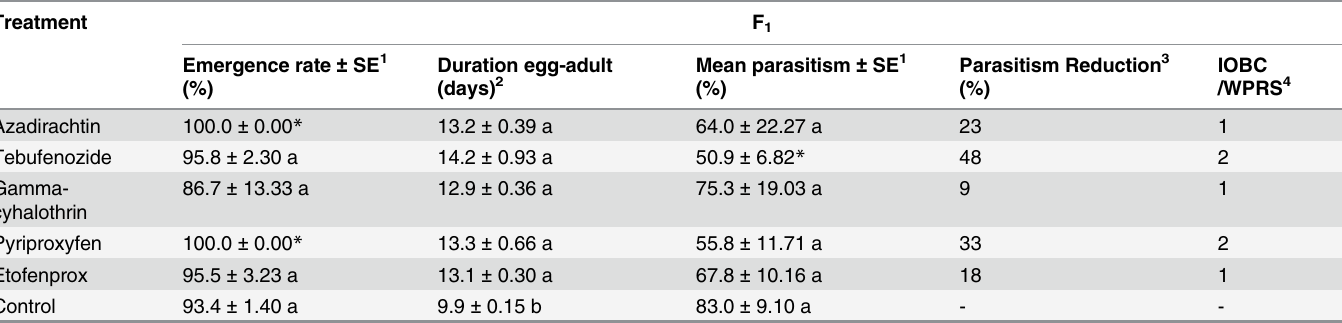
Table 5. Biological parameters, parasitism and parasitism reduction of Tamarixia radiata adults of the F 1 generation exposed to residues of differ- ent insecticides, and toxicological class proposed by the IOBC/WPRS, under 25 ± 2°C, 70 ± 10% RH and photoperiod 14 L: 10 D h.